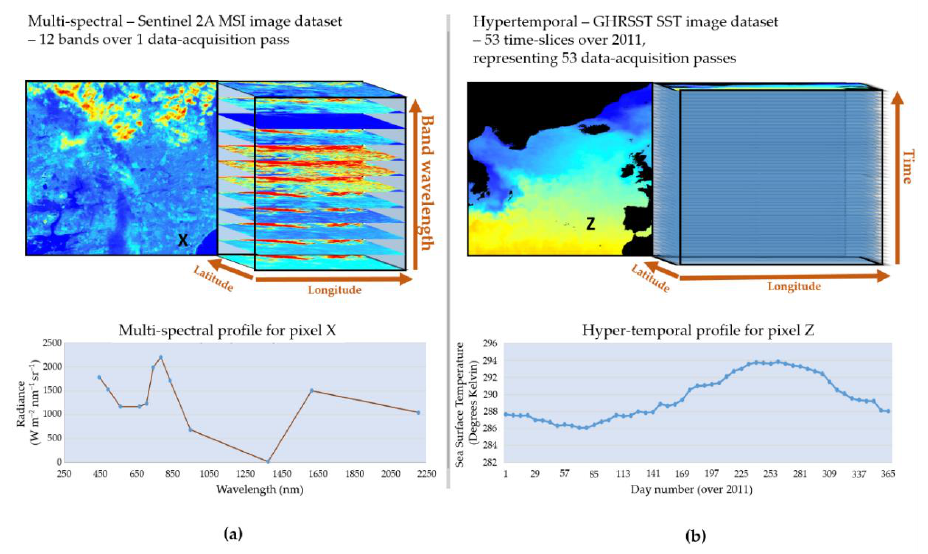
Figure 2. Moving from a spectral to a temporal logic to exploit hypertemporal imagery using existing methodologies. ( a ) Multispectral image data from a single Sentinel-2A MSI acquisition over Southern Ireland on 10 February 2019, with the multispectral signature at point X displayed below. ( b ) Hypertemporal data from 1 year (2011) of level-4 GHRSST sea surface temperature data, processed for the North Atlantic Region, with the hypertemporal signature at point Z displayed below. Both three-dimensional datacubes (latitude, longitude, and either band or time) can contain pixel-based signatures, with the temporal signatures containing the inherent sequencing provided by time. Methodologies founded upon a spectral logic can therefore be adapted along a temporal logic.